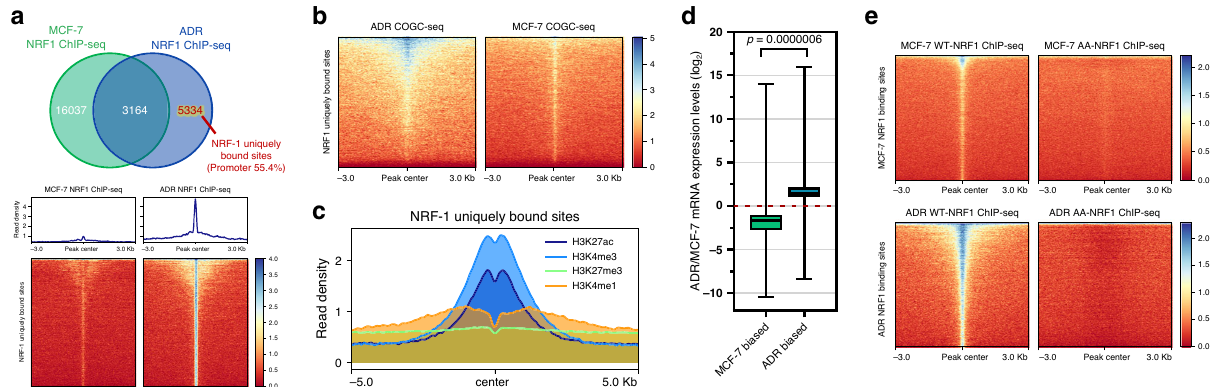
Fig. 7 Genotoxicity-induced O-GlcNAc enhances NRF1 transcriptional regulatory function. a NRF-1 ChIP-seq signal in NRF-1 uniquely bound sites identi fi ed by overlapping MCF-7 and ADR NRF-1 peaks. Upper panel: Venn diagram showing the overlap of NRF-1 peaks in MCF-7 and ADR cells. The percentage of peaks annotated to promoter regions is indicated. Lower panel: Heat map representation of NRF-1 signal enrichment (red, low; blue, high) at NRF-1 uniquely bound sites. The enrichment levels were pro fi led ±3 kb from the peak center. b Heat map representation of COGC-seq signal enrichment (red, low; blue, high) at NRF-1 uniquely bound sites. The enrichment levels were pro fi led ±3 kb from the peak center. c Average enrichment pro fi les of published H3K27ac, H3K4me3 (GSE97481), H3K27me3 (GSE96363) and H3K4me1 (GSE86714) ChIP-seq reads at NRF-1 uniquely bound sites. d The box plots showing the mRNA expression changes (RNA-seq FPKM) of NRF1-binding genes associated with MCF-7- and ADR-biased peaks. The box plots show the medians (black lines), 25th and 75th percentiles (boundaries), and minimum/maximum values (whiskers). The p value (0.0000006, two-sided unpaired Student ’ s t -test, calculated between multiple genes in each group) is indicated. n = 2 biologically independent RNA-seq replicates. Source Data are provided as a Source Data fi le. e Heat map representation of WT-NRF-1 and AA-NRF-1 signal enrichment (red, low; blue, high) at NRF-1 binding sites in MCF-7 and ADR cells. The enrichment levels were pro fi led ±3 kb from the peak